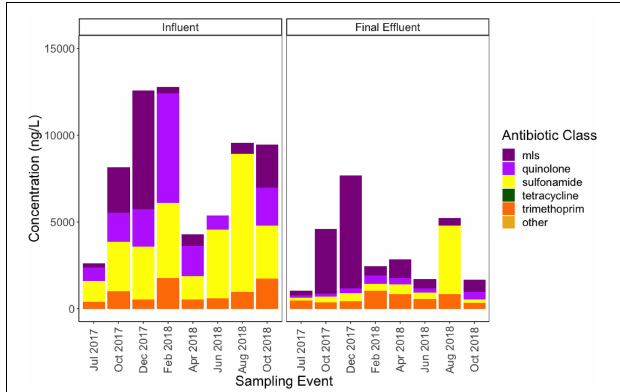
FIGURE 10 | Concentrations of antibiotics (ng/L) detected via high performance liquid chromatography-tandem mass spectrometry in influent and final effluent samples grouped by resistance class. The methods applied were as described previously (Singh et al., 2019). MLS indicates antibiotics belonging to the macrolide, lincosamide, and streptogramin classes. Tetracycline and other (i.e., tylosin) antibiotics were tested but not detected in wastewater